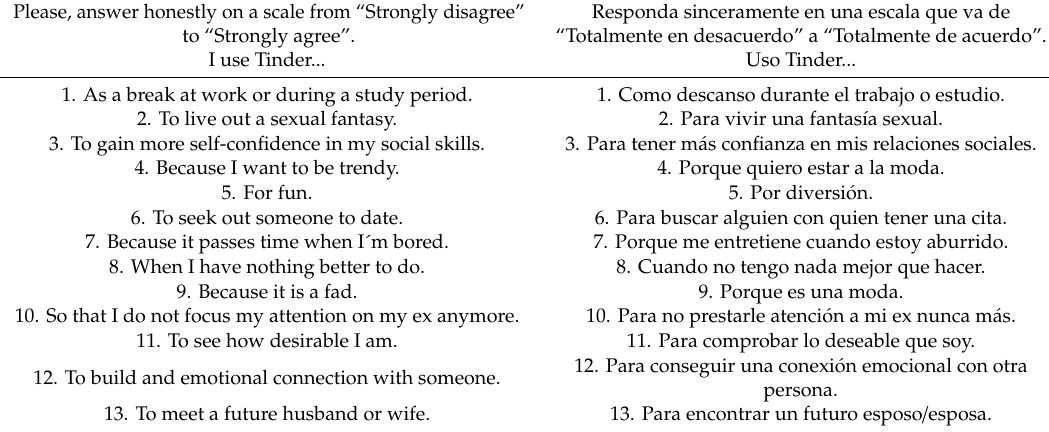
Table A1. Spanish version of the Tinder Motives Scale